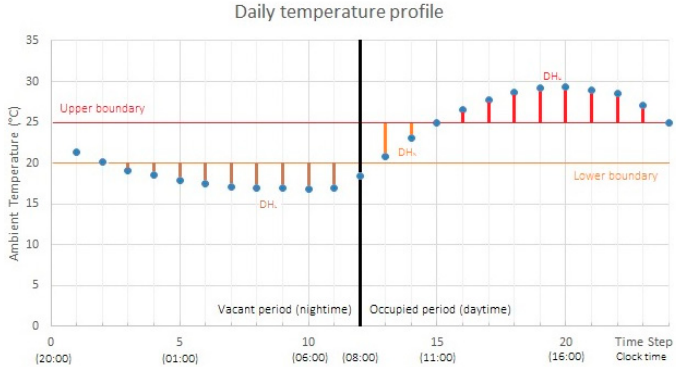
Figure 2. Daily temperature profile (as simulated) for Penrith between 27 January 20:00 and 28 January 20:00 in 2014. The upper and lower boundaries can be seen at 25 and 20 degrees respectively. The DH for each time step are calculated as the difference from the base temperature at each period.